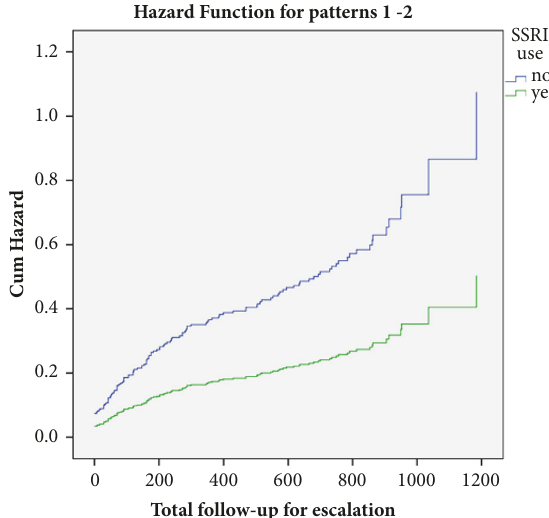
Figure 2: Cumulative hazard for escalation of medical therapy in response to uncontrolled IBD between patients with abnormal anxiety or depression scores at baseline receiving or not receiving antidepressants.